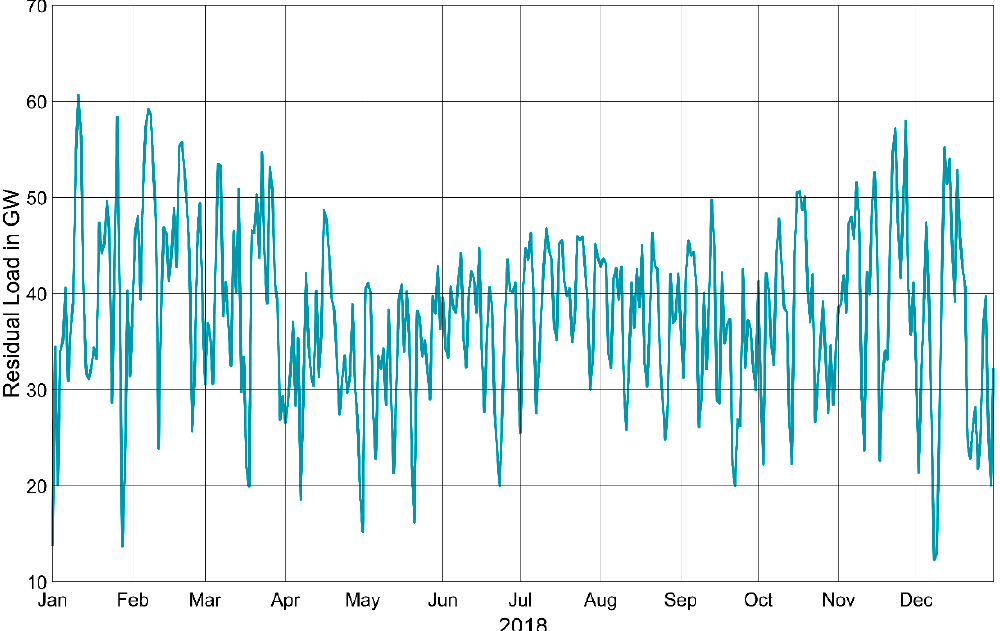
Figure 2. Residual load of Germany in 2018 based on the data of Agora Energiewende [20]. The data source used is the Agorameter published by Agora Energiewende [20], which uses data directly from the European association for the cooperation of transmission system operators for electricity (ENTSO-E) and the European Energy Exchange (EEX) stated in Leipzig ( Germany) . The following power plants are used to determine the generation curve of inflexible REs such as: